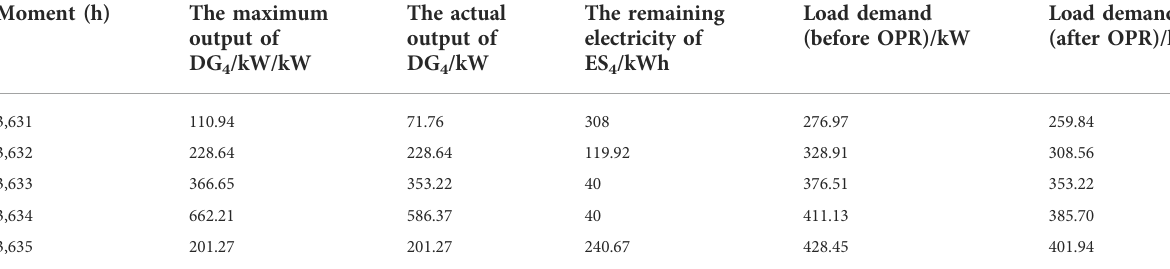
TABLE 2 The DG output and load demand from 3,631 h to 3,635 h.